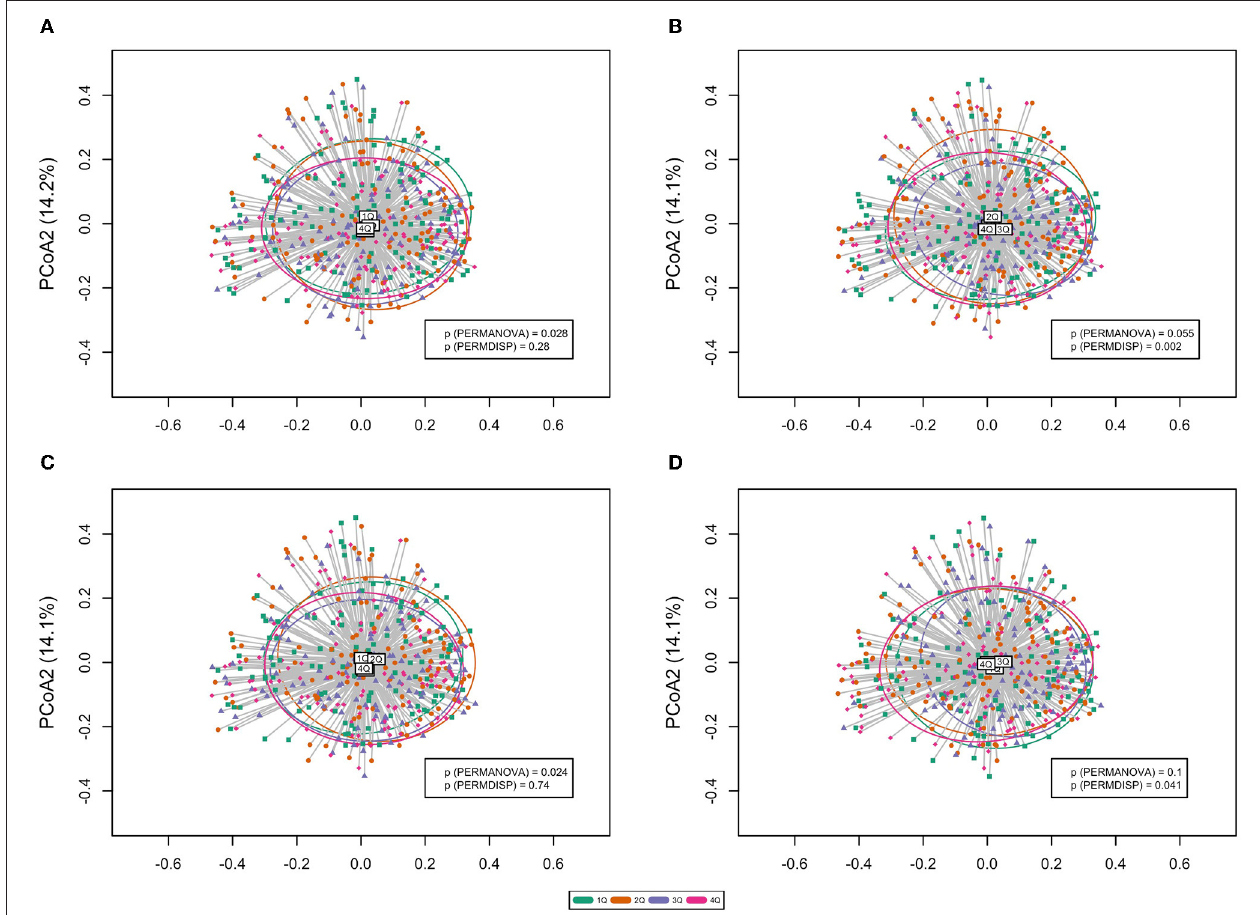
FIGURE 3 | Principal coordinates analysis (PCoA) plot of the oral microbiome beta diversity (Bray–Curtis dissimilarity) at the genus level. Ellipses stand for 68% of data coverage. Lines are connected between samples and the corresponding group spatial median. p values from both PERMANOVA and PERMDISP tests are given in the plot. (A) Methylparaben; (B) propylparaben; (C) molar sum of parabens; and (D)